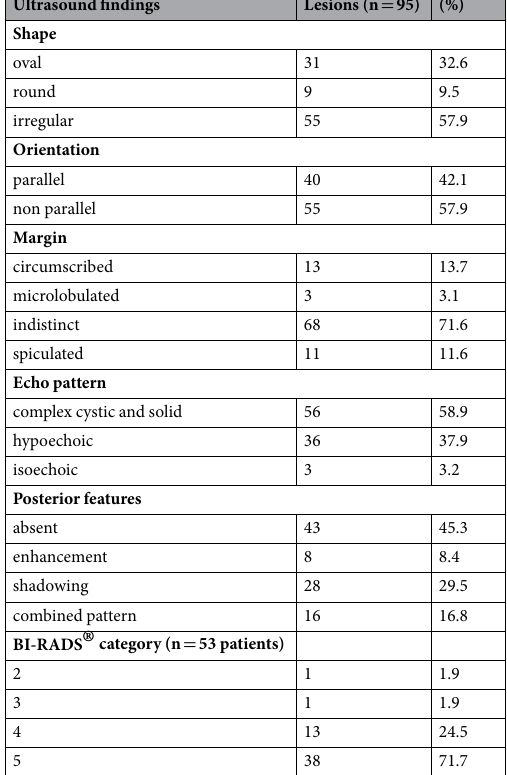
Table 6. Ultrasound findings in IHM (n = 95